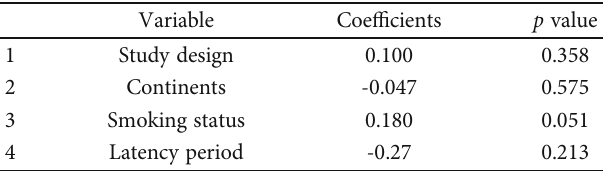
Figure 3: HR of the risk of lung cancer subgrouped by adjustment for smoking status of patients. Table 3: Metaregression analysis of possible covariates for lung cancer risk.